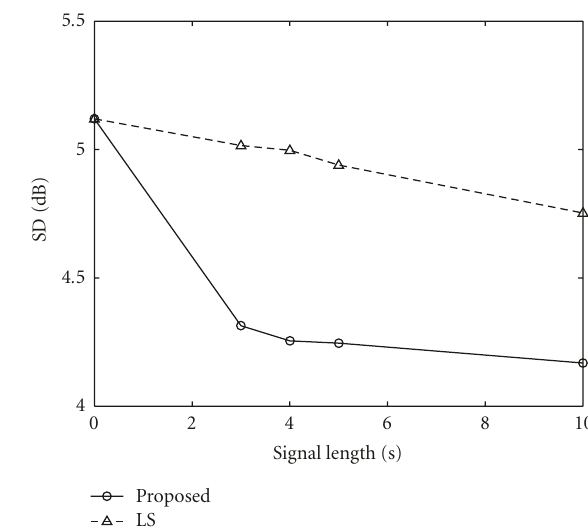
Figure 4: RASTI as a function of observed signal length. Figure 5: SD as a function of observed signal length.